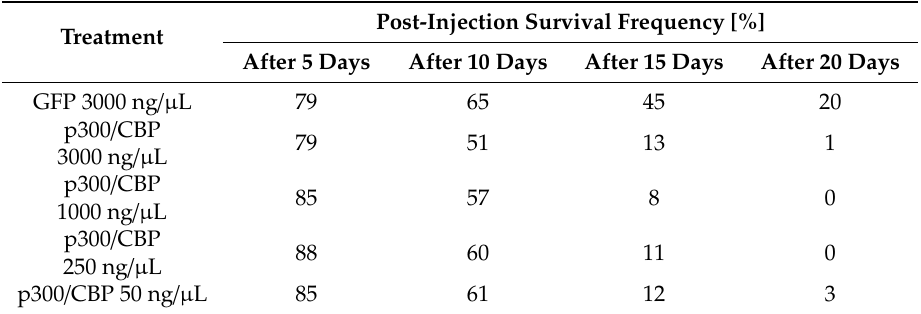
Table 1. Survival frequency [%] of aphids 5-, 10-, 15- and 20-days